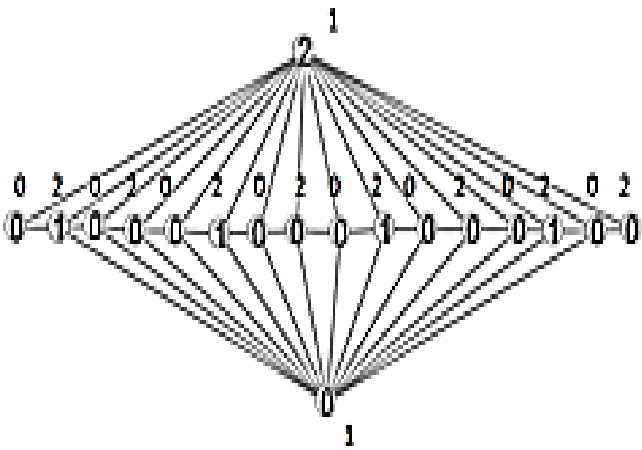
Figure 10 . Switching with modular coloring in